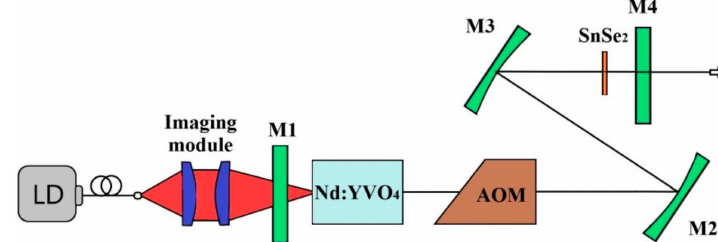
Figure 3. The setup of the APDM QML